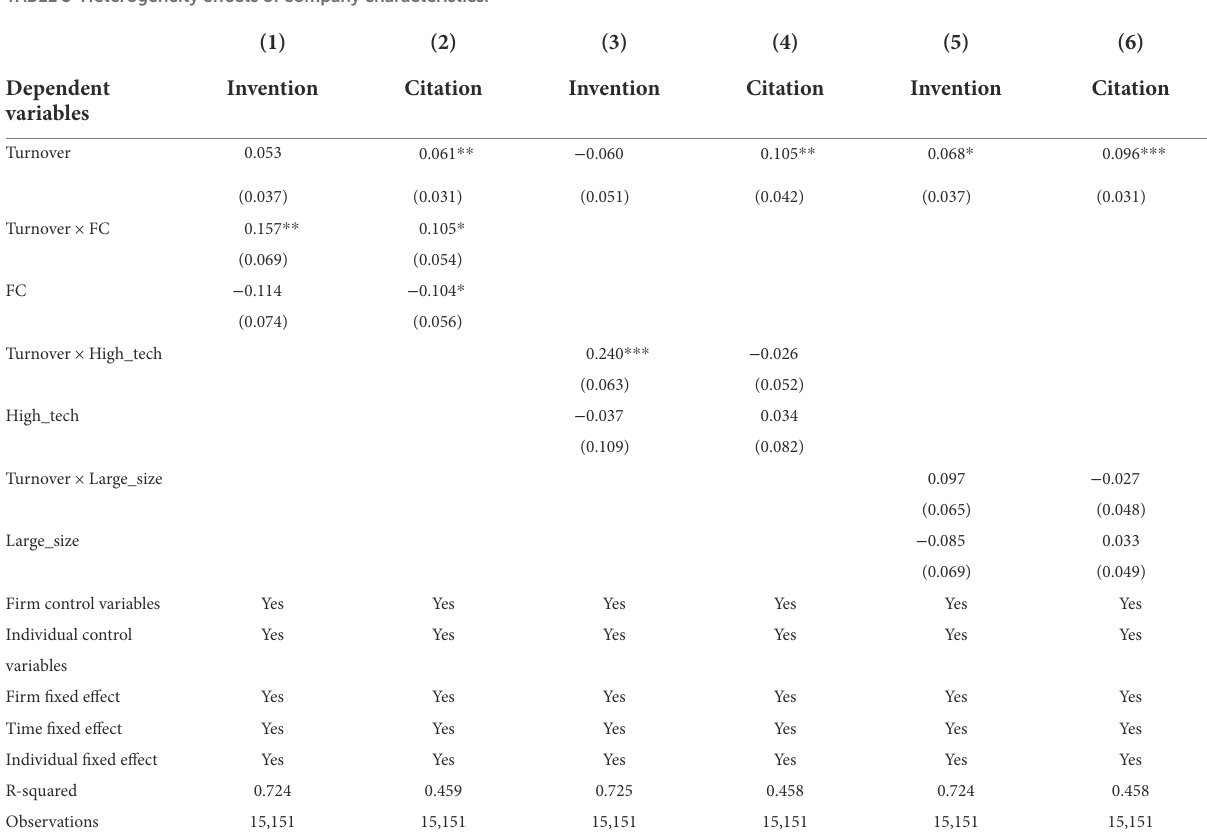
TABLE 5 Heterogeneity effects of company